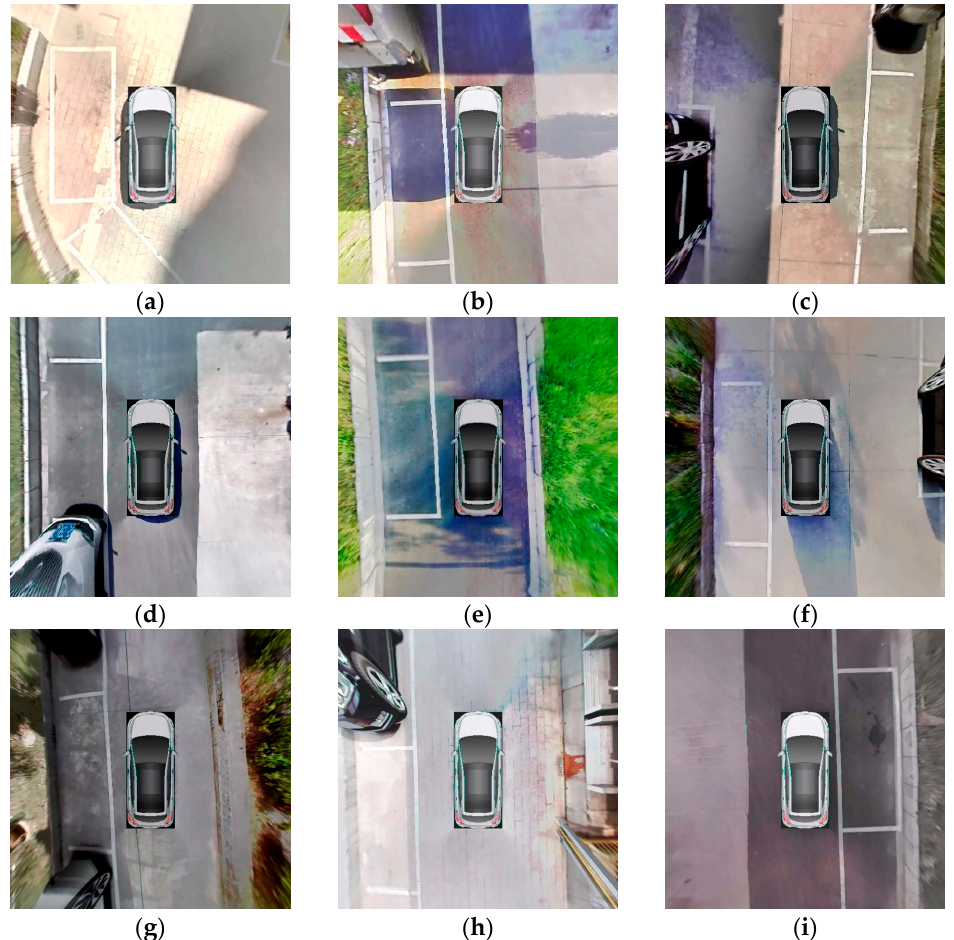
Figure 7. Parking environment for capturing intelligent parking driving models: ( a ) Strong light illumination and curbstone obstacles; ( b ) front-side vehicle obstacle and curbstone obstacles; ( c ) front and left-side vehicle obstacle and curbstone obstacles; ( d ) vehicle obstacle and curbstone obstacles and covered parking slot lines; ( e ) left- and right-side curbstone obstacles; ( f ) right-side vehicle obstacle and curbstone obstacles and fuzzy parking slot line; ( g ) rainy day; ( h ) sunny day; and ( i ) ideal parking environment.